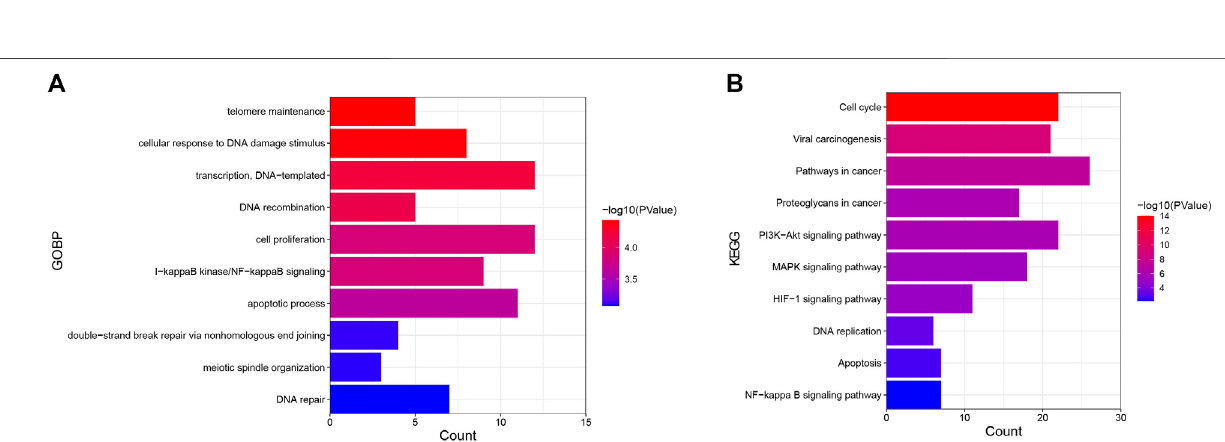
Frontiers in Pharmacology |